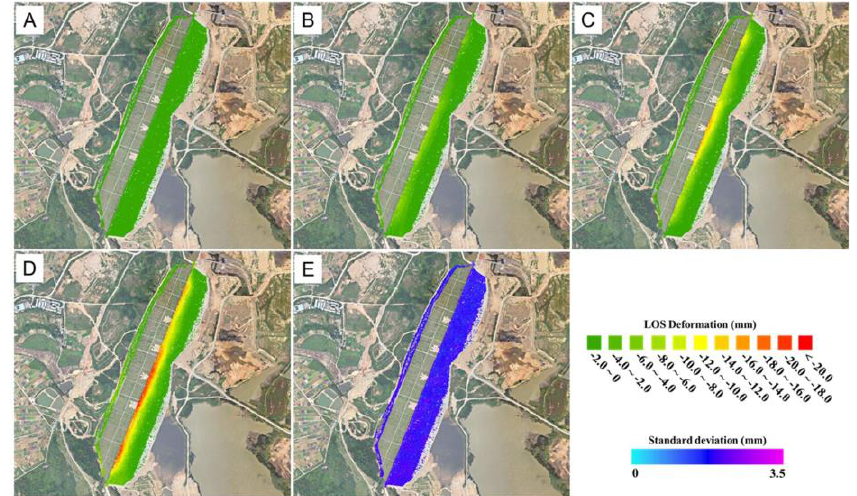
Figure 14. The deformation series results of the upstream slope in descending orbit TSX-SL: ( A ) date: 10/08/2017, ( B ) date: 04/10/2017, ( C ) date: 28/11/2017, ( D ) date: 31/12/2017, and ( E ) residual error.